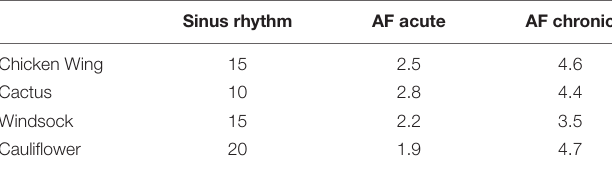
TABLE 3 | Maximum velocity in sinus rhythm, AF acute, and AF chronic [cm/s].